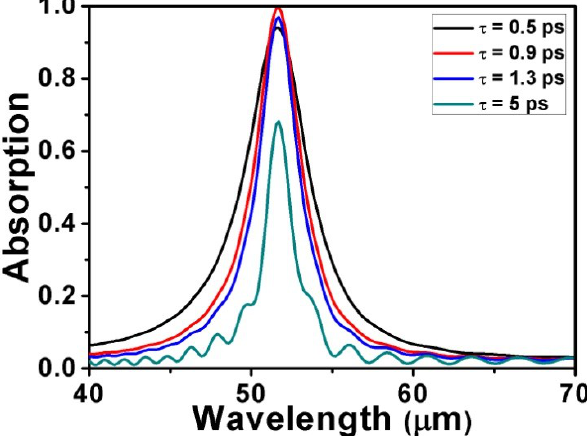
Figure 6. Absorption spectra for different relaxation times with other parameters fixed.